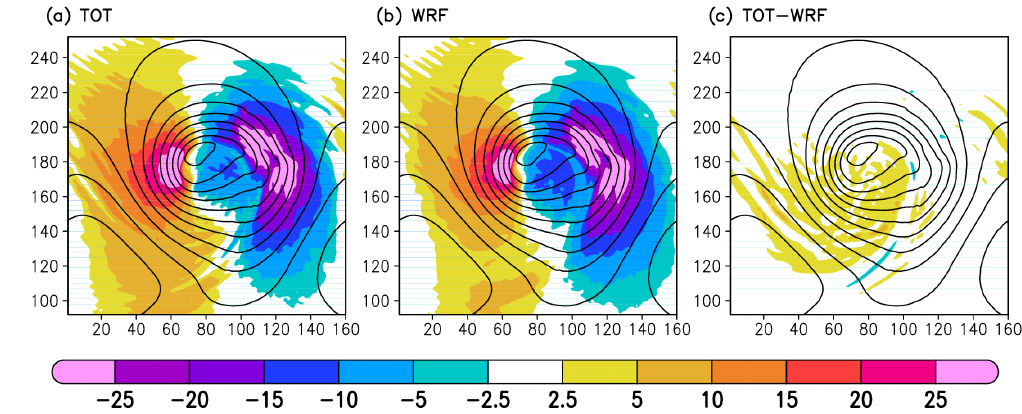
Figure 6. As Fig. 1, but for the height tendency at 900hPa. Unit is mh − 1 .